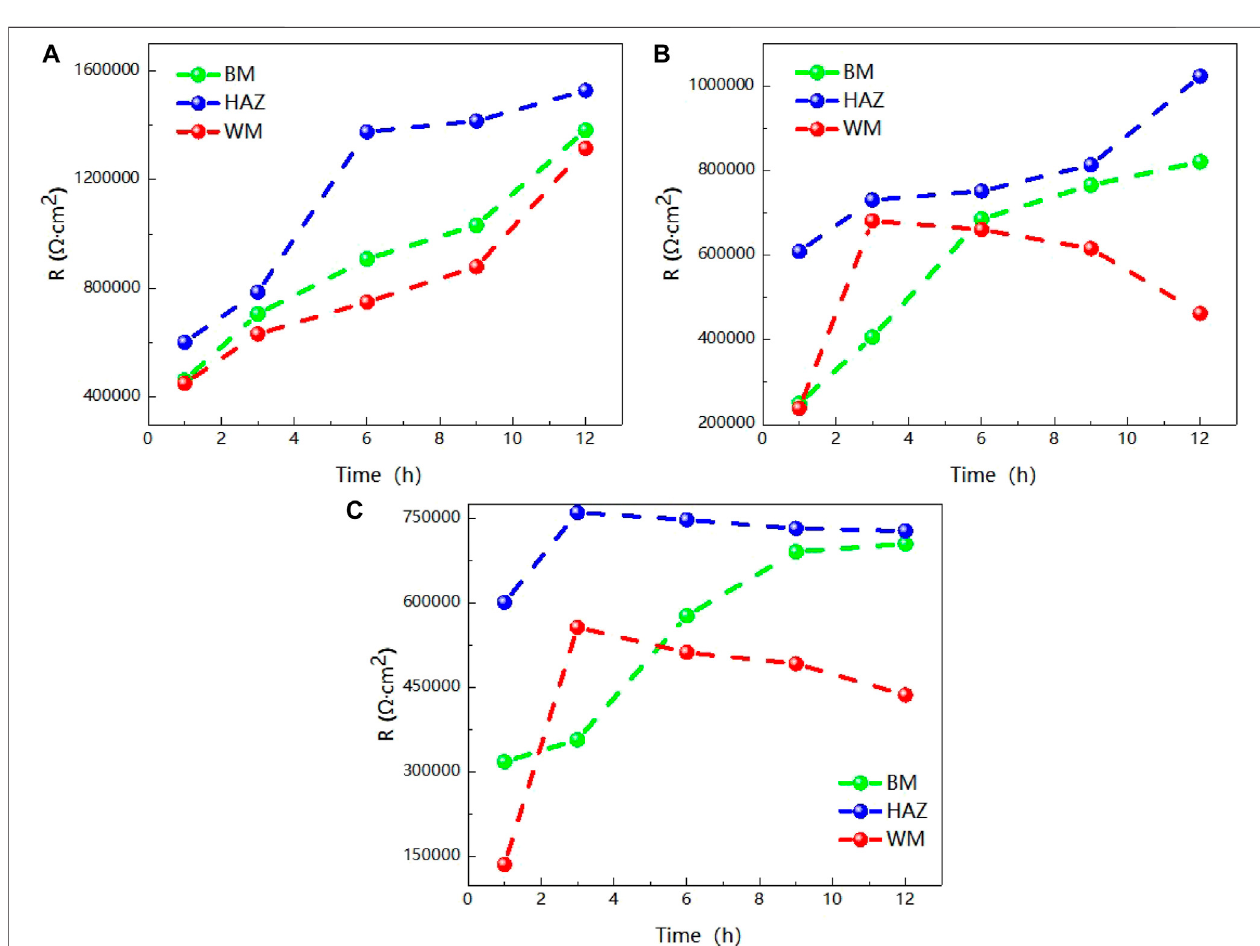
FIGURE 6 | Impedance changes of the three regions over time (A) 25 ° C (B) 35 ° C (C) 45 ° C.